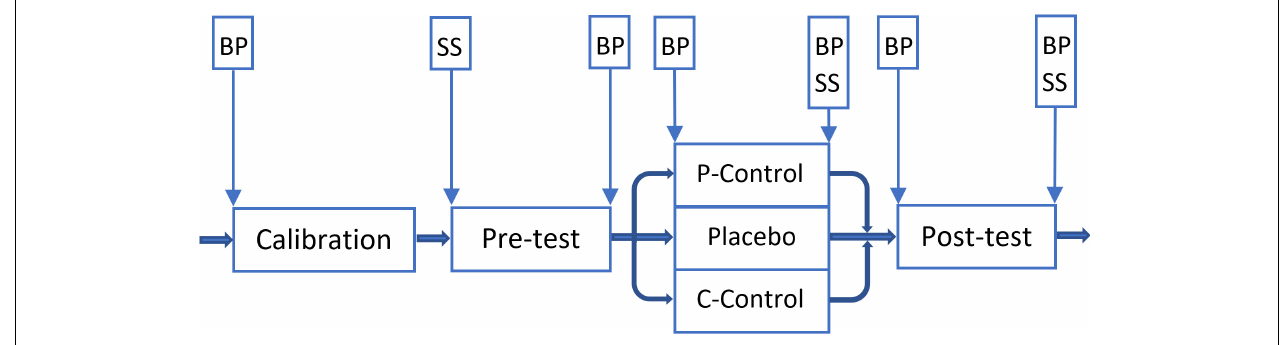
FIGURE 4 | Overview of the Experiment Two. Vertical boxes: spots where subjective stress/arousal (SS) and/or blood pressure (BP) were measured. A 5-min break was given to participants between phases. P-Control: PCG. Placebo: PG. C-Control: CCG.